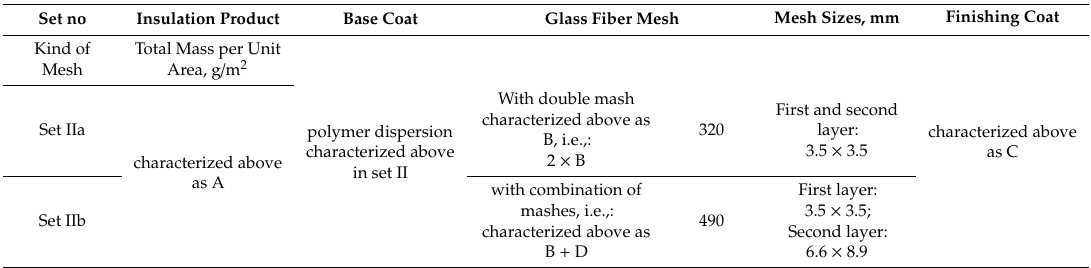
Table 1. Configuration of thermal insulation systems for additional